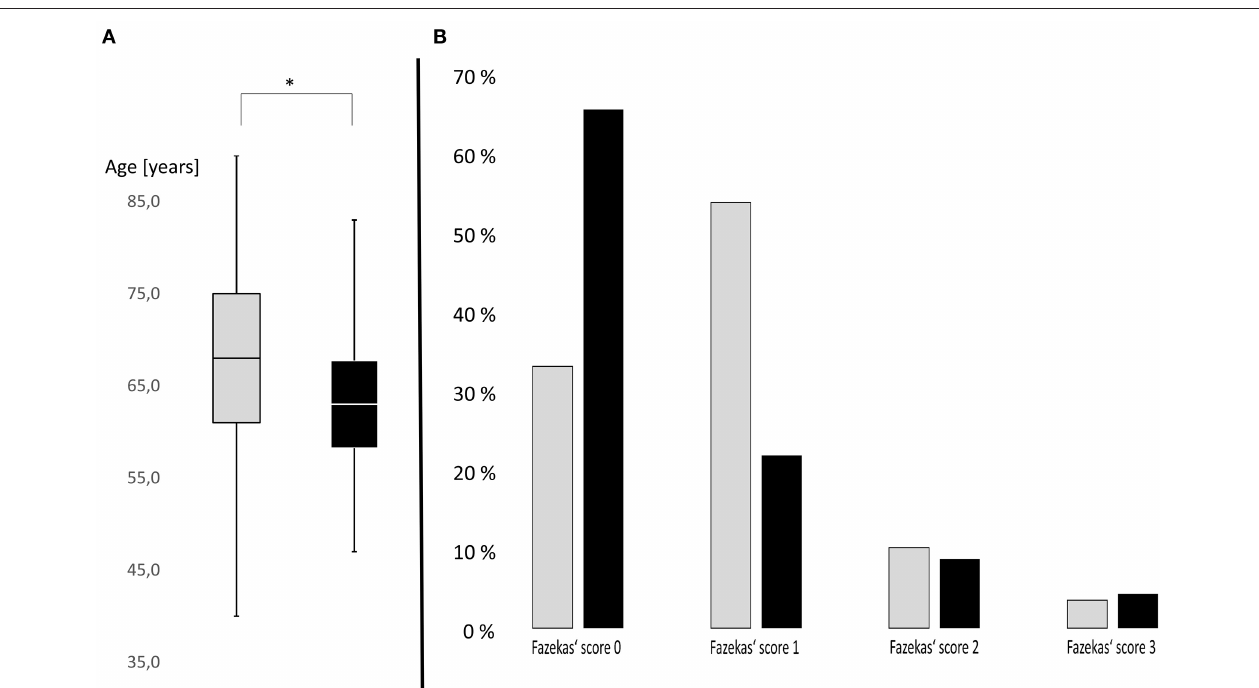
FIGURE 1 | (A) Box plots of age distribution in patients with subsequent recurrence (black) and without subsequent recurrence (gray). Transient global amnesia (TGA) patients with subsequent recurrence were significantly younger than patients without recurrence ( p = 0.032). Y -axis: age of patients in years. * p < 0.05. (B) Severity distribution of cerebral microangiopathy using Fazekas’ score in TGA patients with subsequent recurrence (black) and without subsequent recurrence (gray). TGA patients with subsequent recurrence are more likely to have no microangiopathy, while microangiopathy is more common in TGA patients without subsequent recurrence. Y -axis: Distribution in